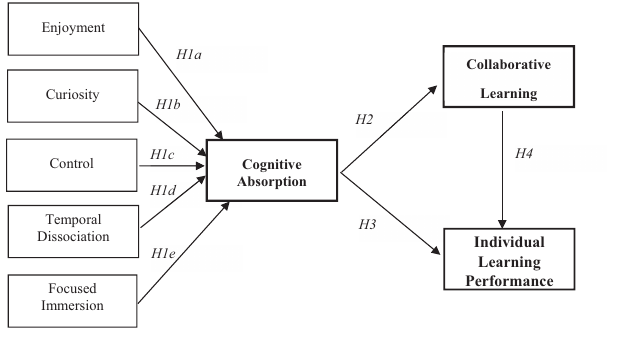
Figure 2. Conceptual